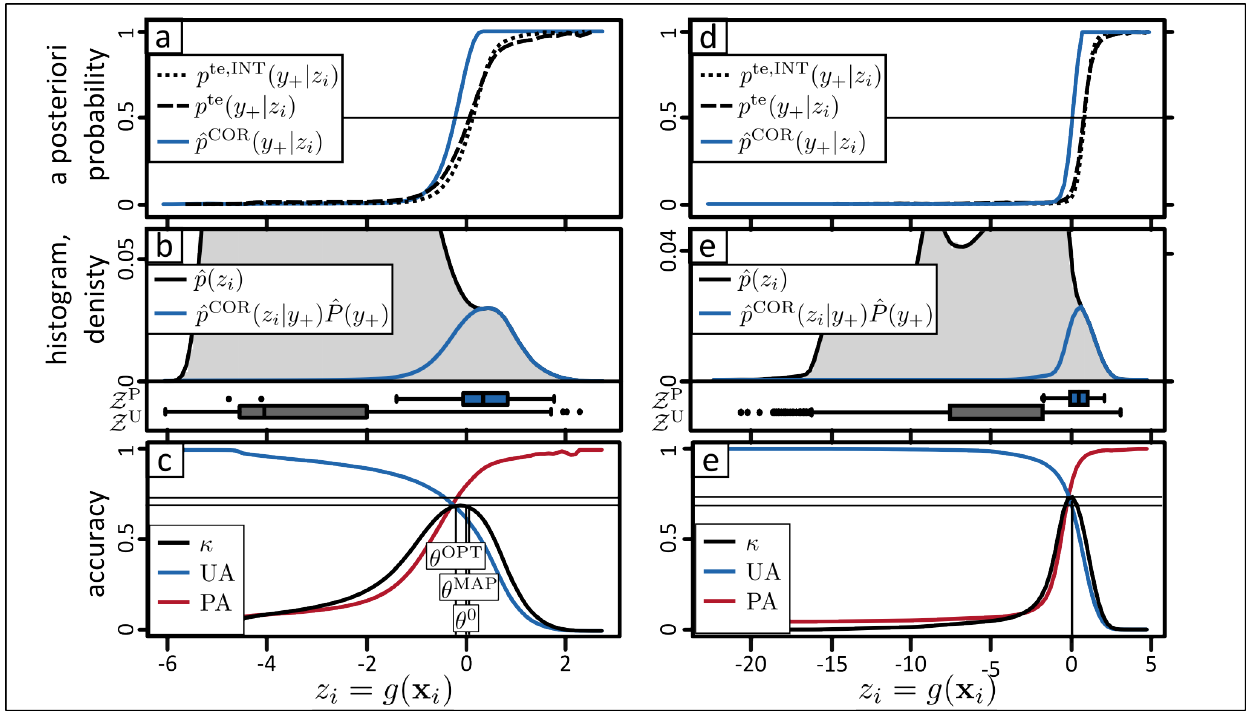
Figure 6. A posteriori probabilities, diagnostic plot, and threshold dependent accuracy for the manually selected model ( a – c ) and the optimal model ( d – f ) of the barley example (see also Figure 5).